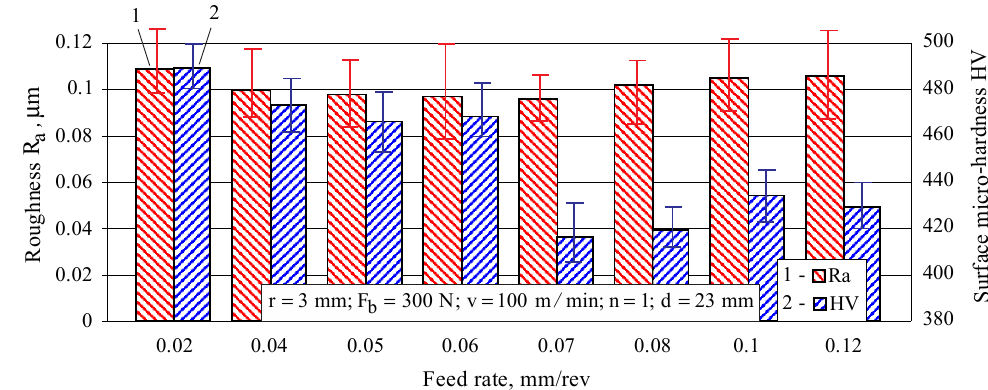
Figure 8. Effect of the feed rate on the roughness parameter R a and surface micro-hardness.